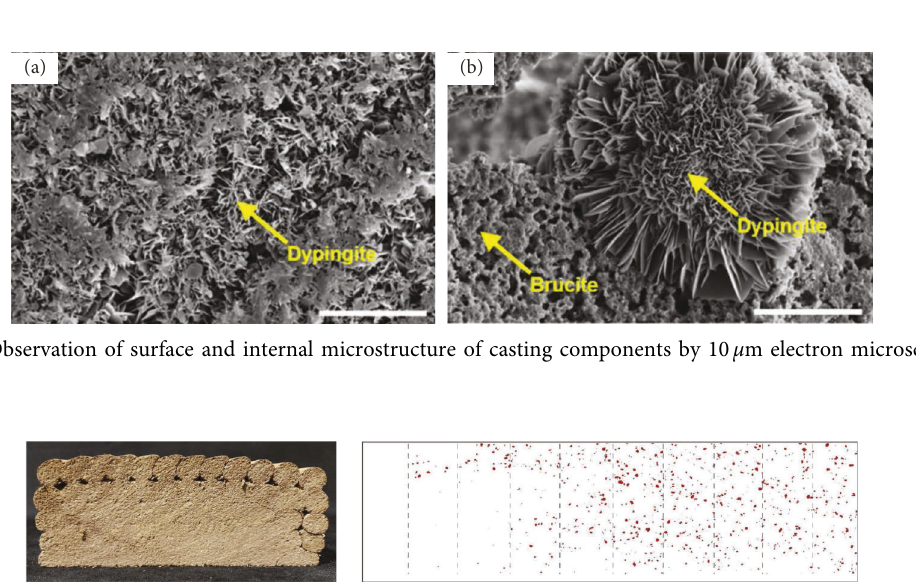
Figure 20: Setting time of sulphoaluminate cement doped with construction waste additives lithium carbonate (a) and boric acid (b)